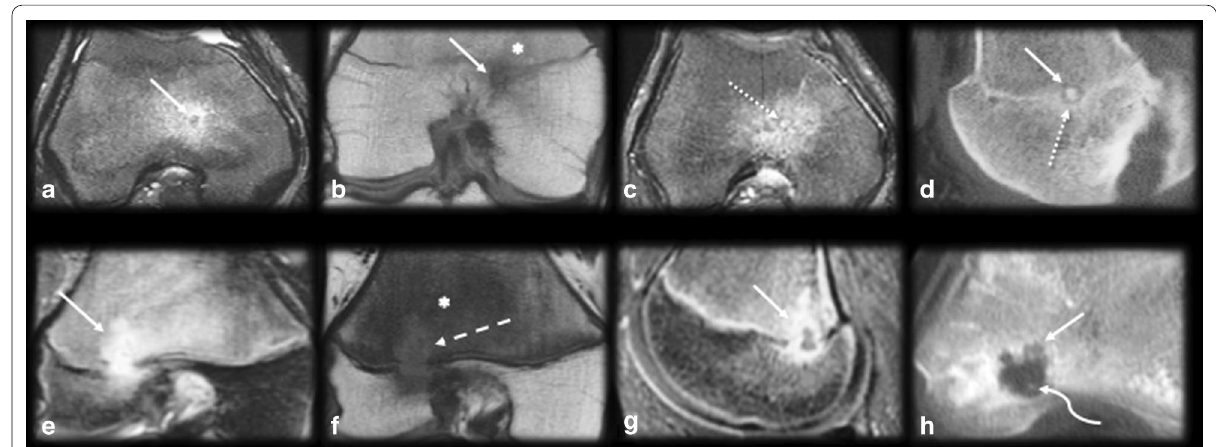
Fig. 8 Osteoid osteoma versus osteomyelitis. ( a – d ) Male, 15 years old, presenting with knee pain for 2 months. MRI T2 FS ( a ), T1 ( b ), T1 FSGD ( c ) and CT ( d ) showed a nidus with smooth margins (arrows), a central mineralized portion (dashed arrows), homogeneous gadolinium enhancement (dotted arrows) and hazy T1 bone marrow edema around the lesion (asterisk). ( e – h ) Male, 13 years old, presenting with knee pain for 6 weeks. MRI T2 FS ( e ), T1 ( f ), T1 FS GD ( g ) and CT ( h ) showed a bone abscess with irregular margins and peripheral enhancement (arrows). Note there was mild bone marrow edema (asterisk), a positive penumbra sign (dashed arrow in f ) and a small peripheral bone sequestrum (curved arrow in h